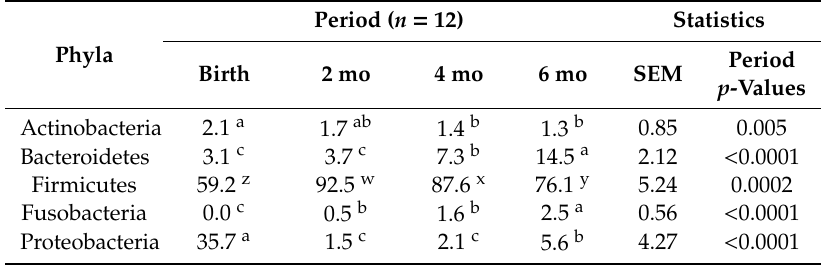
Table 1. Oral bacterial phyla over time in human infants (% of sequences). Phyla